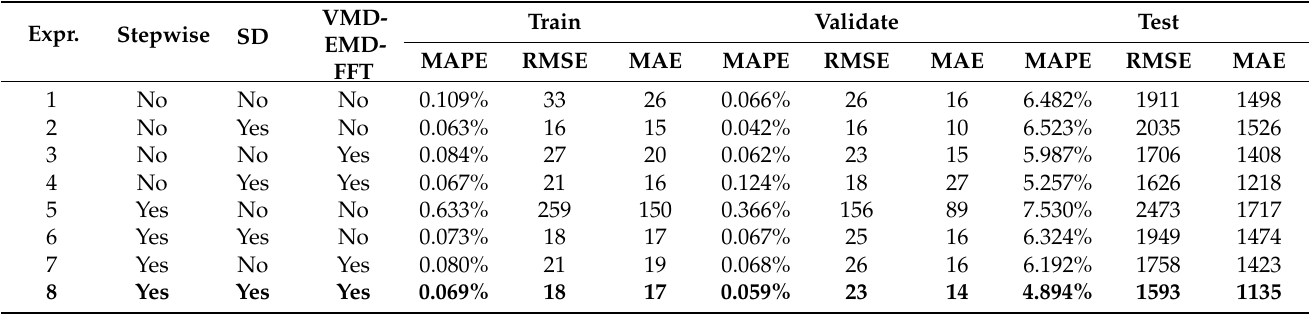
Table 7. Results of the eight experiments when applying with training dataset.